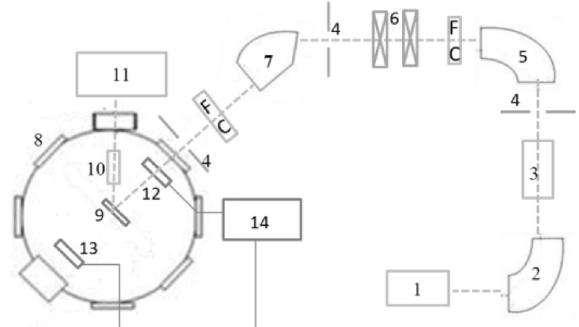
Figure 1. Schematic drawing of experiment setup: 1, ECR ion source, 2, analyzing magnet, 3, high volt accelerate platform, 4, barrier, 5, 90° deflection magnet, 6, magnetic quadrupled lens, 7, 60 ◦ deflection magnet, 8, ultrahigh vacuum target chamber, 9, target, 10, silicon drift detector, 11, X-ray recording system, 12, penetrable faraday cup, 13, common faraday cup, 14, projectile number recording